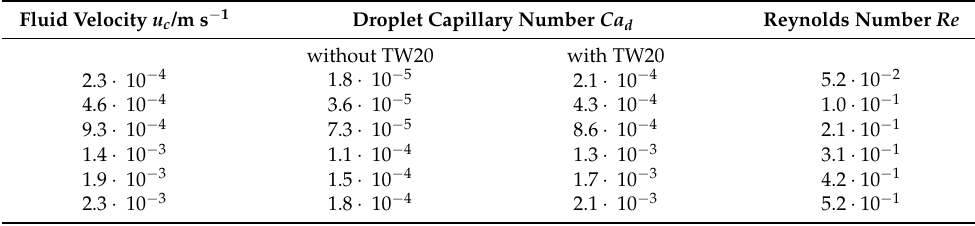
Table A2. Important dimensionless numbers for the fluid velocities in the microfluidic channel. The fluid properties listed in Table A1 were used for the